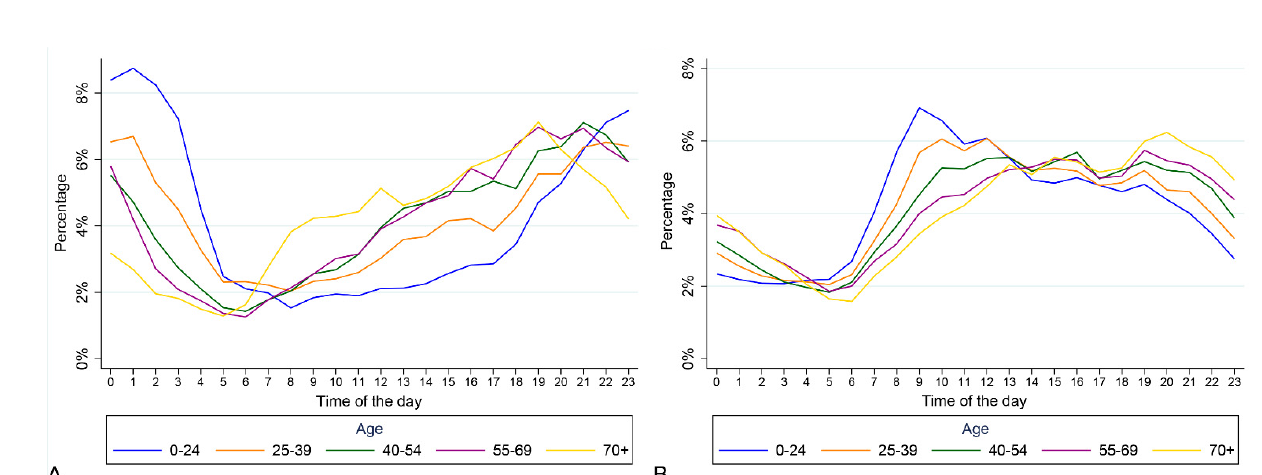
Figure 2. Distribution of alcohol-related callouts (panel A ) and non – alcohol – related callouts (panel B ) during hour of the day by weekend and weekdays.